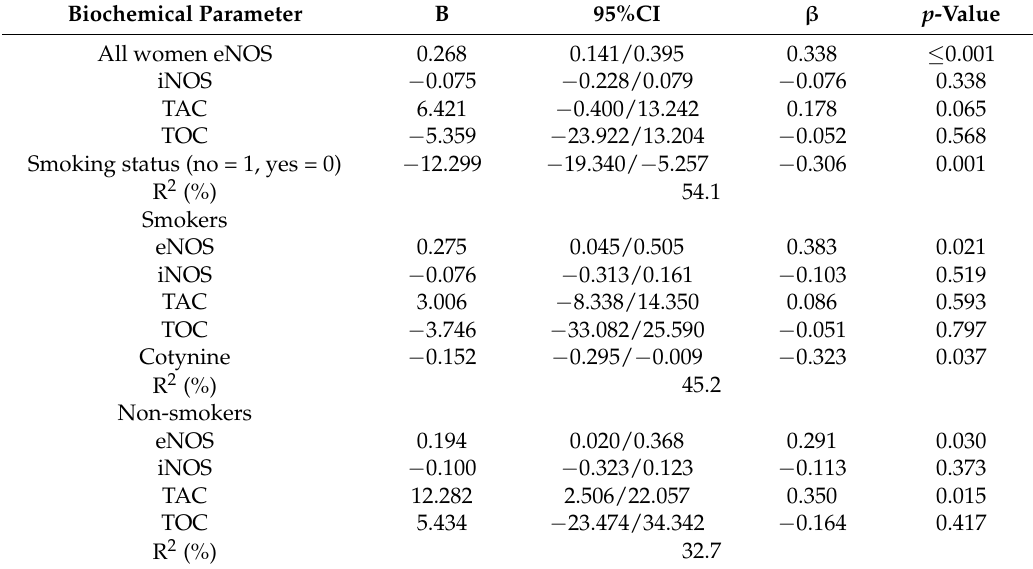
Table 5. Multivariable regression analyses (adjusted for age, gestational age, BMI) of NO with eNOS iNOS, markers of oxidative stress and smoking status in the whole group of studied women (n = 99), smoking women (n = 42), and tobacco abstinent group (n =